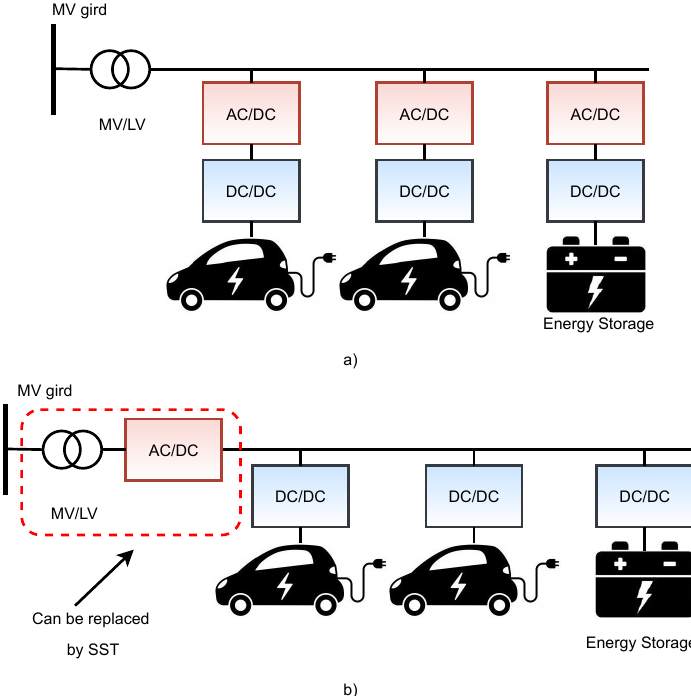
Figure 3. Structure of a fast-charger station: ( a ) with AC distribution network ( b ) with DC distribu- tion